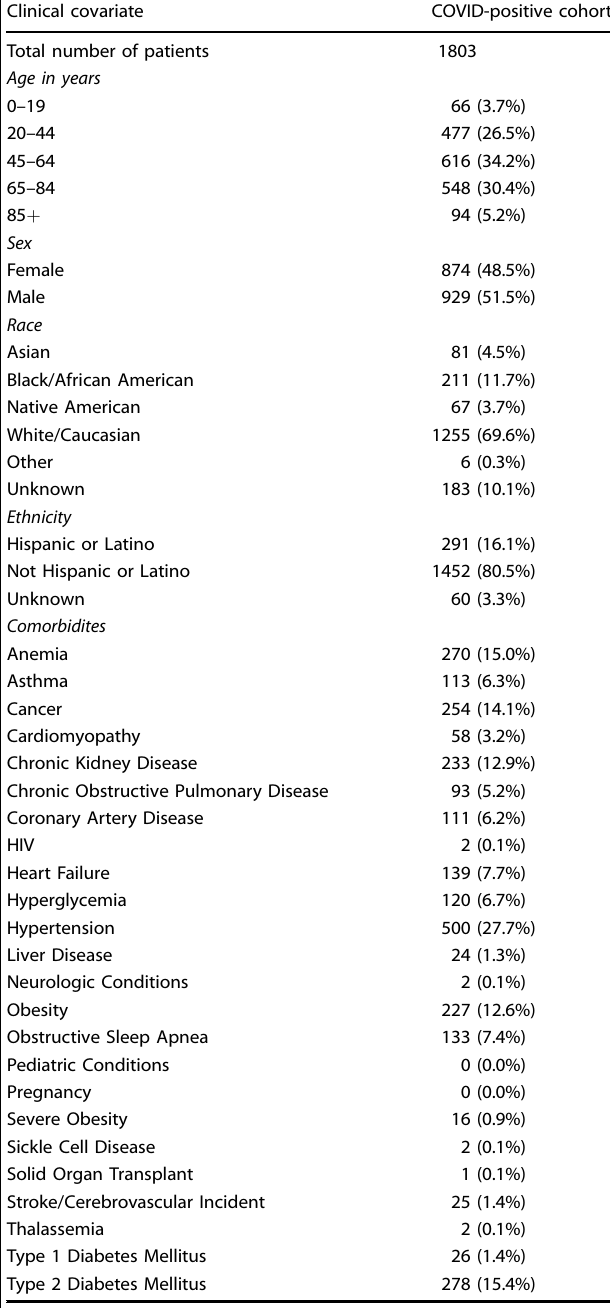
Table 1. General clinical characteristics of the study population.